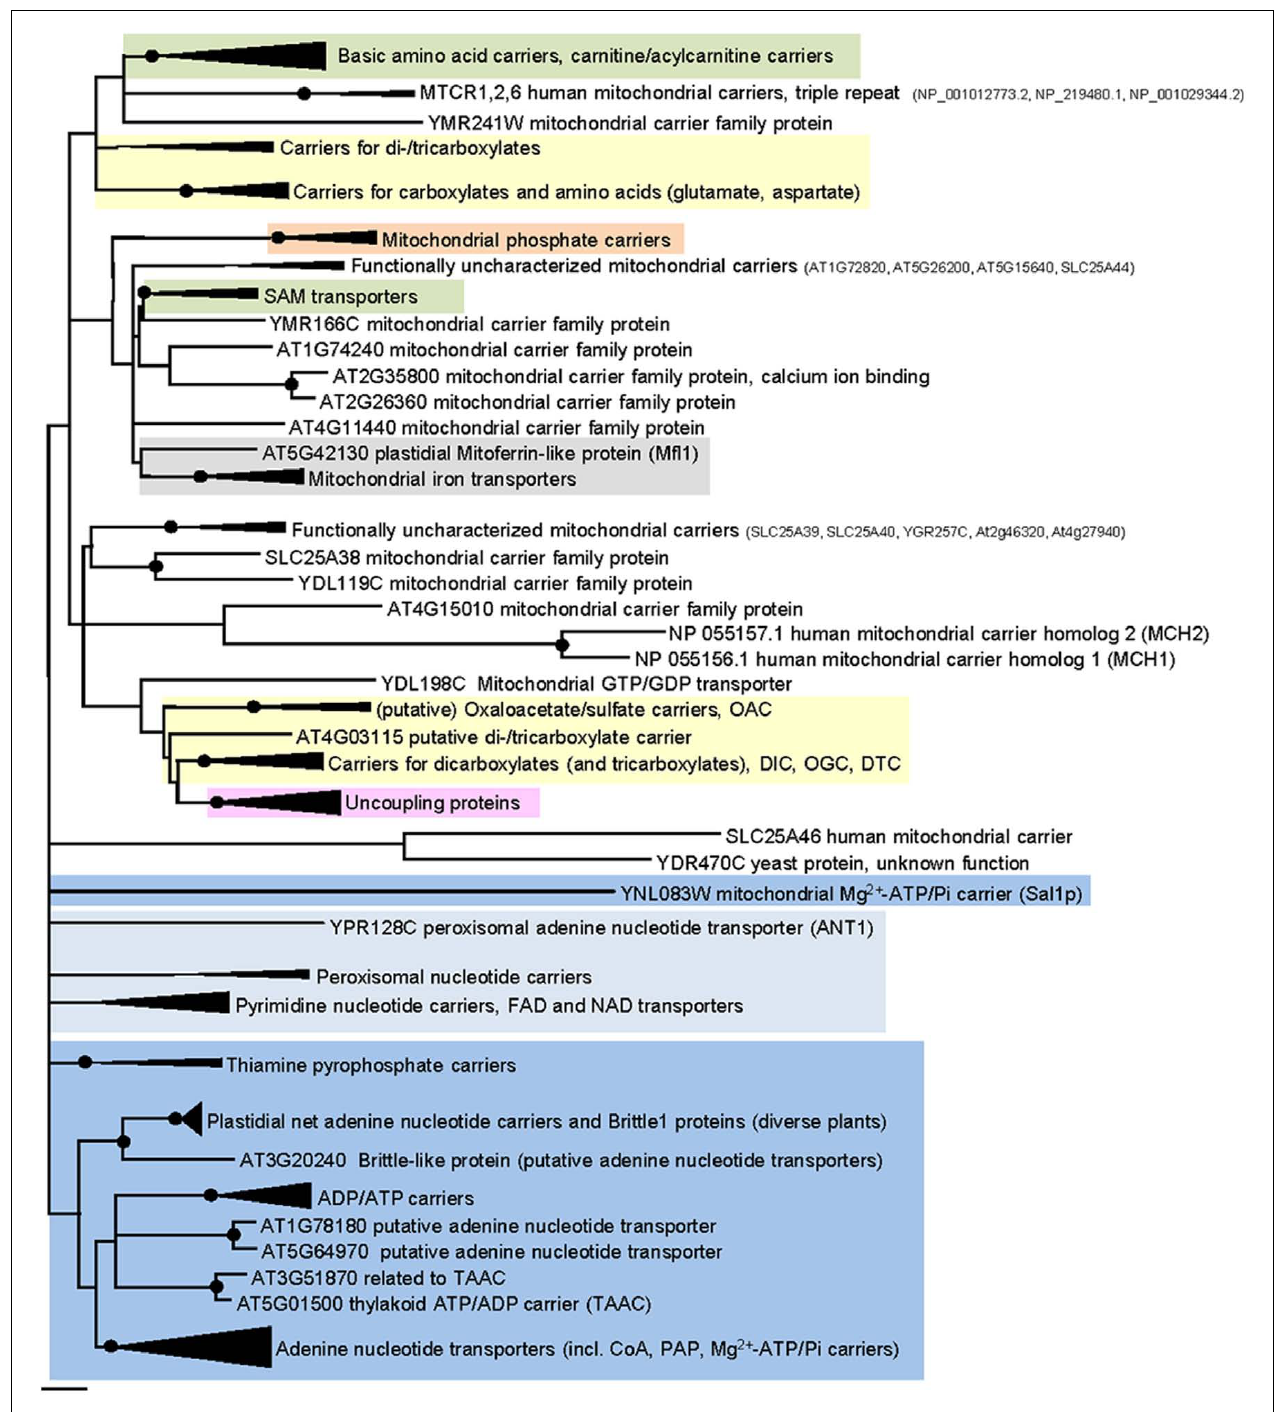
70 are indicated by black dots. Different functional groups (clusters or sub-clusters) are shaded: basic amino acid carriers, carnitine/acylcarnitine carriers, and SAM transporters in green, carriers for carboxylates, dicarboxylates, tricarboxylates, glutamate, and aspartate in yellow, mitochondrial phosphate carriers in orange, iron transporters in gray, uncoupling proteins in purple, peroxisomal ADP/ATP carriers, pyrimidine nucleotide, FAD, and NAD carriers in very pale blue, adenine nucleotide and thiamine pyrophosphate transporters transporters in blue).The shaded subsets are displayed in detail in FiguresA1 – A5 in